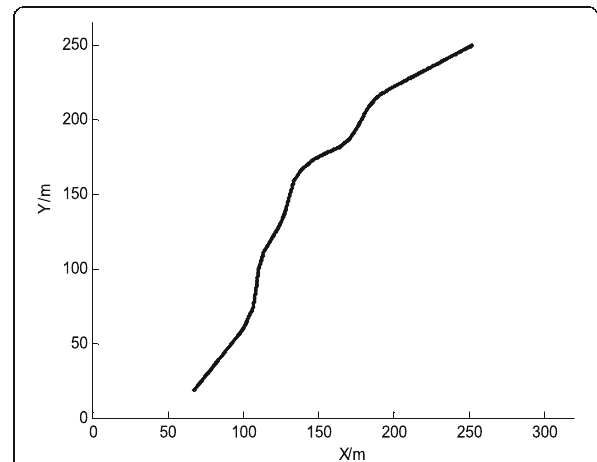
Fig. 3 Running track. The trajectory in this figure is the trajectory of the robot in Fig. 2b when Q learning method is applied in path planning